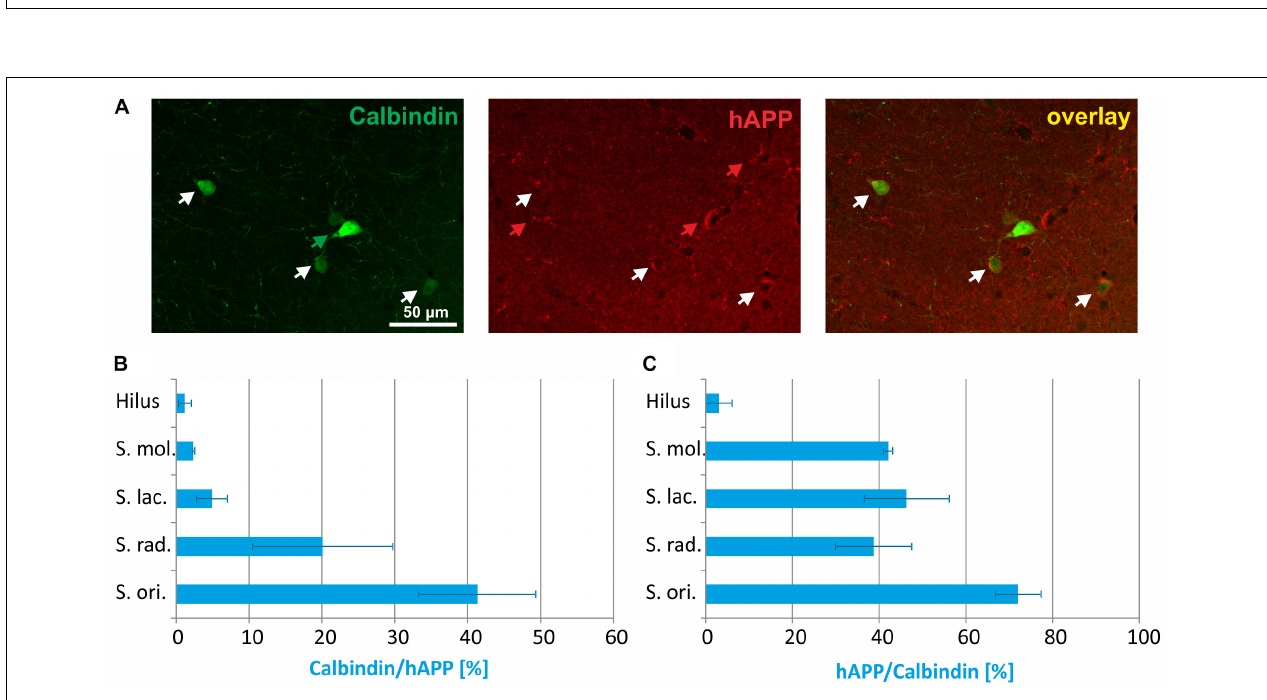
FIGURE 2 | Quantitative analyses of the co-localization between parvalbumin-immunoreactive neurons and hAPP-expressing interneurons in hippocampus of Tg2576 mice. Typical examples of double labelings in stratum oriens are shown in panel (A) . White arrows point to double-labeled neurons, green, and red arrows to neurons that are only labeled by green (parvalbumin) and red (hAPP) fluorescence, respectively. Quantitative analysis revealed that of all hAPP transgene-expressing interneurons 0% (in stratum lacunosum moleculare ) to 25% (in stratum oriens ) were parvalbumin-immunoreactive (B) . Of all parvalbumin-expressing neurons, 60 to